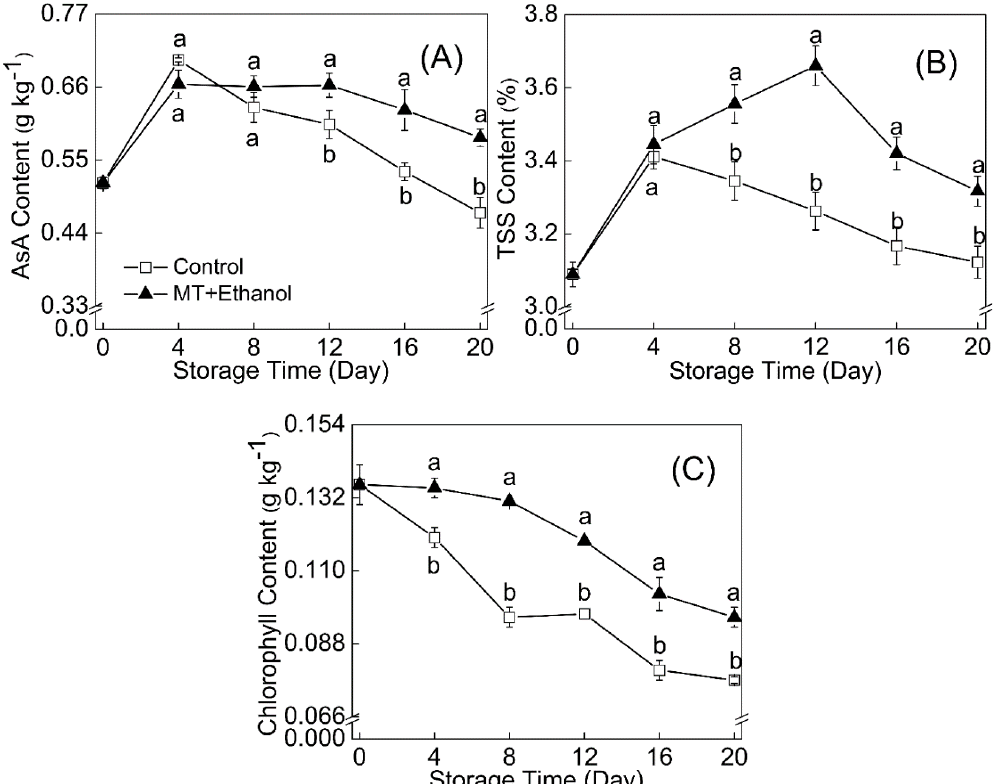
Figure 3. Effect of MT combined with ethanol treatment on ascorbic acid (AsA) ( A ), total soluble solids (TSSs) ( B ), and chlorophyll content ( C ) were presented. Results were expressed as mean ± SD of triplicate assays. Vertical bars represent the standard errors of the means. Significant differences ( p < 0.05) are represented by different letters.